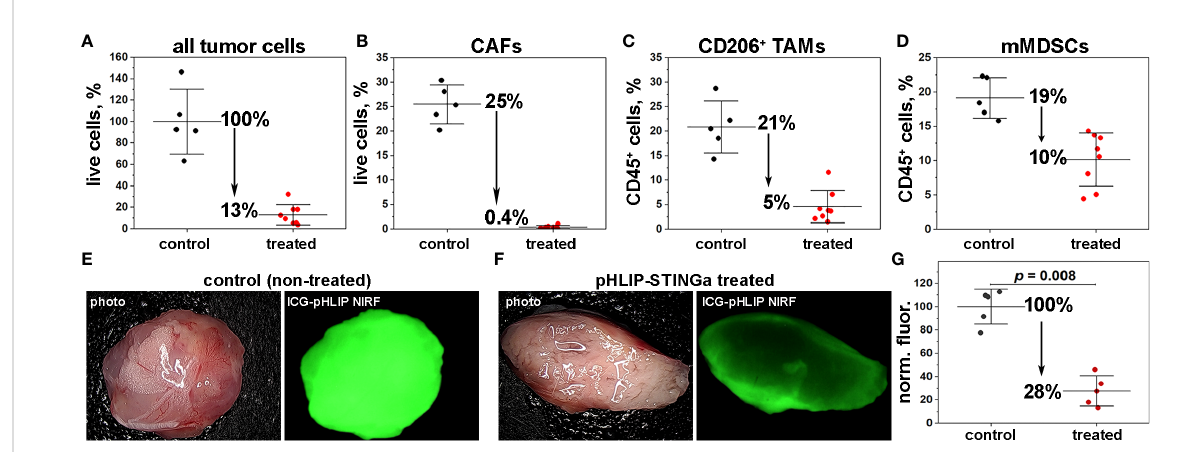
FIGURE 4 Obliteration of tumor stroma and pH increase within the TME. (A – D) The numbers of cells within the TME in control (mice receiving vehicle as a single IP injection) and treated (mice receiving a single IP injection of Al647-pHLIP-STINGa (100 m M 300 m l)) were established by FACS analysis. The percentages of all live cells with TME (A) , the number of CAFs (CD3 - , CD45 - , CD140b + ) quanti fi ed as % of all live cells (B) , the numbers of TAMs (CD45 + , CD11b + , F4/80 + , CD206 + ) (C) and mMDSCs (CD45 + , CD3 - , CD11b + , F4/80 - , Ly6C hi , Ly6G - ) (D) both quanti fi ed as % of CD45 + immune cells are shown (all points, mean and St.D., the p-levels for all graphs < 0.002). (E – G) pH imaging with ICG-pHLIP and quanti fi cation of the signal are shown. Mice bearing CT26 tumor in right fl ank (about 100 mm 3 ) were divided into 2 groups (5 animals per group). One group (treated) was treated with a single IP injection of pHLIP-STINGa (100 m M 300 m l) on day 1 and another group (control) did not receive any treatment. On day 3 an ICG-pHLIP pH-imaging probe was given in single IP injections (50 m M 100 m l) to both control (non-treated) and pHLIP- STINGa treated groups, and 24 hrs later (on day 4), animals were euthanized, tumors were collected, cut in half and imaged, the representative images are shown on panels (E, F) and normalized mean fl uorescence signal calculated for all tumor pieces (5 animals per group) are shown on panel (G) (all points, mean and St.D. are shown, p - level was calculated using the Kolmogorov-Smirnov two-tailed nonparametric